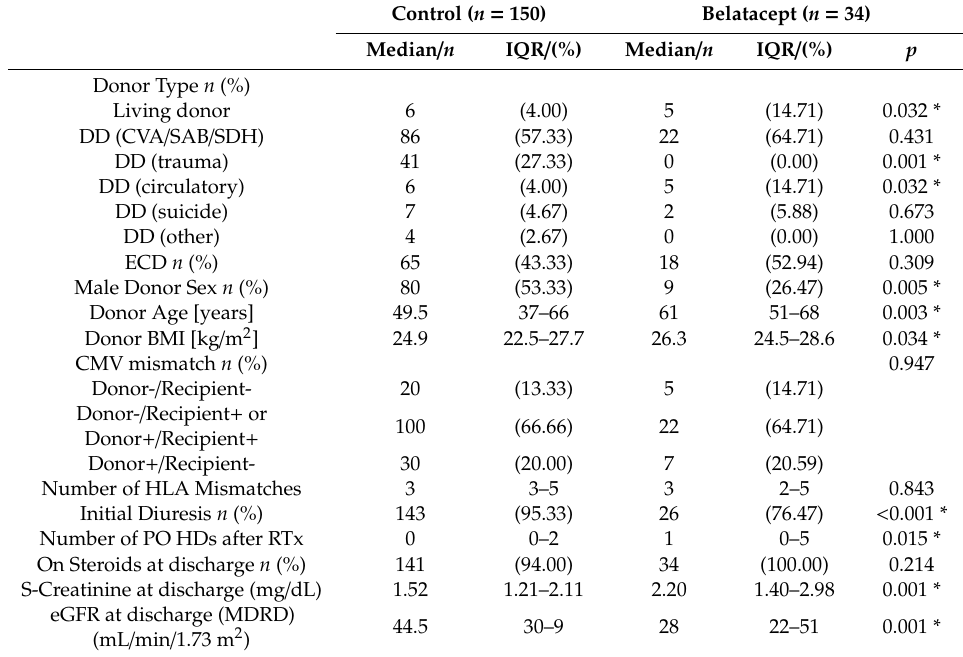
Table 2. Data at the time of Renal Transplantation